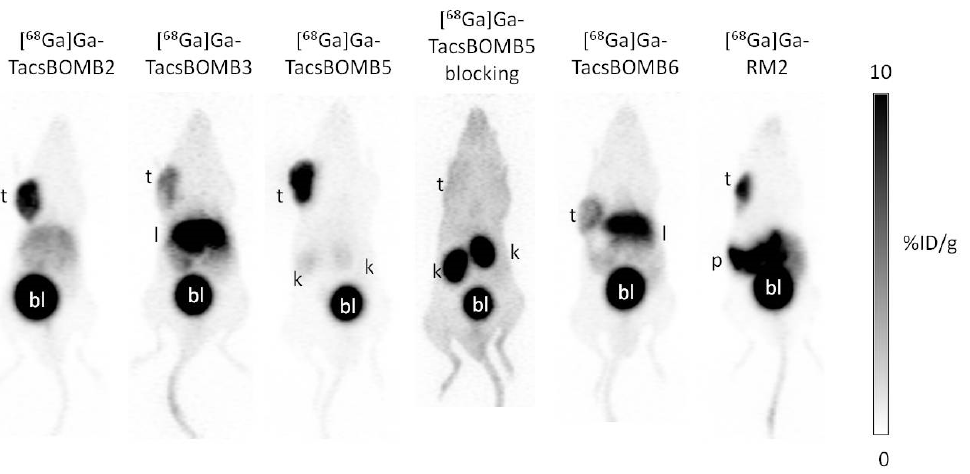
Figure 4. Representative maximum intensity projection PET images of [ 68 Ga]Ga-TacsBOMB2, [ 68 Ga]Ga-TacsBOMB3, [ 68 Ga]Ga-TacsBOMB5, [ 68 Ga]Ga-TacsBOMB6, and [ 68 Ga]Ga-RM2 acquired at 1 h post-injection in mice bearing PC-3 tumor xenografts. t: tumor; l: liver; k: kidney; p: pancreas; bl: urinary bladder.